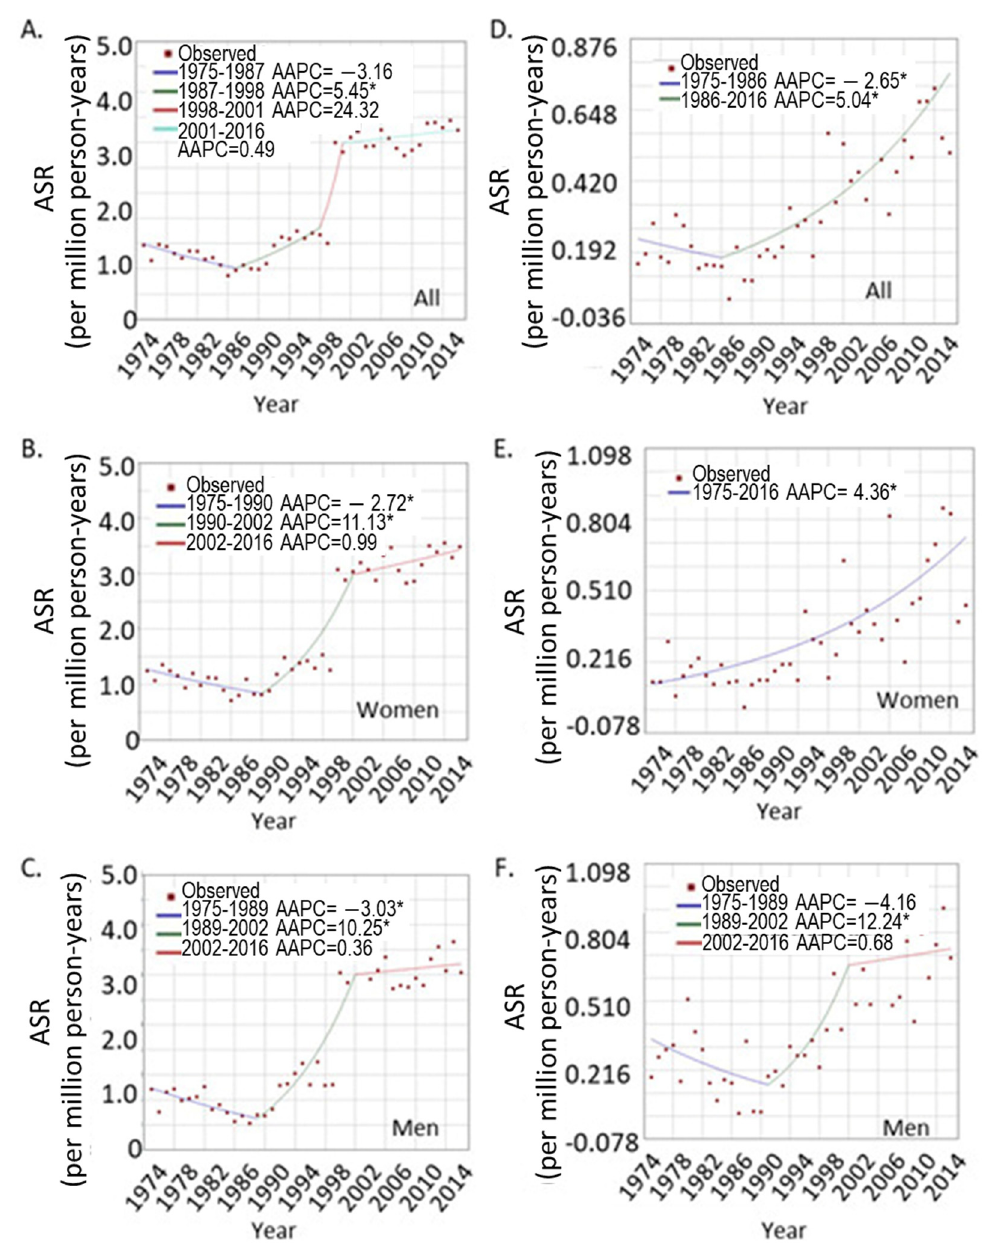
Figure 1. Joinpoint analysis of the UVM trends over the years. ( A – C ), overall trend for UVM at all ages; ( A ), both sexes; ( B ), women; and ( C ), men. ( D – F ), trends for younger patients under age 40; ( D ), both sexes; ( E ), women, ( F ), men. * indicates significant trend of p < 0.05.